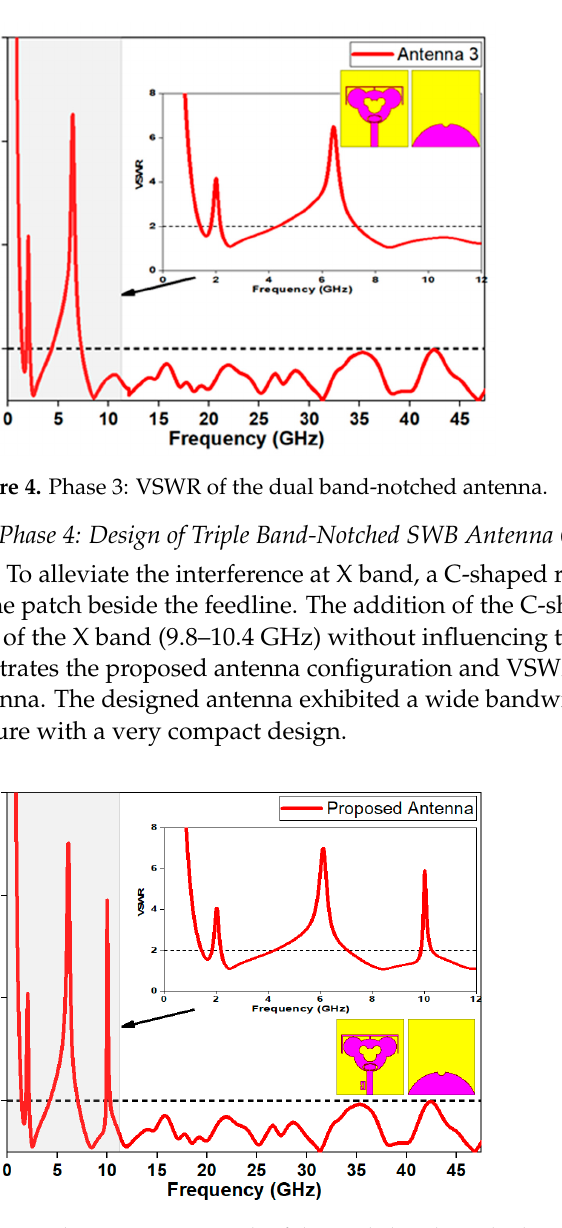
Figure 5. Phase 4: VSWR result of the triple band-notched